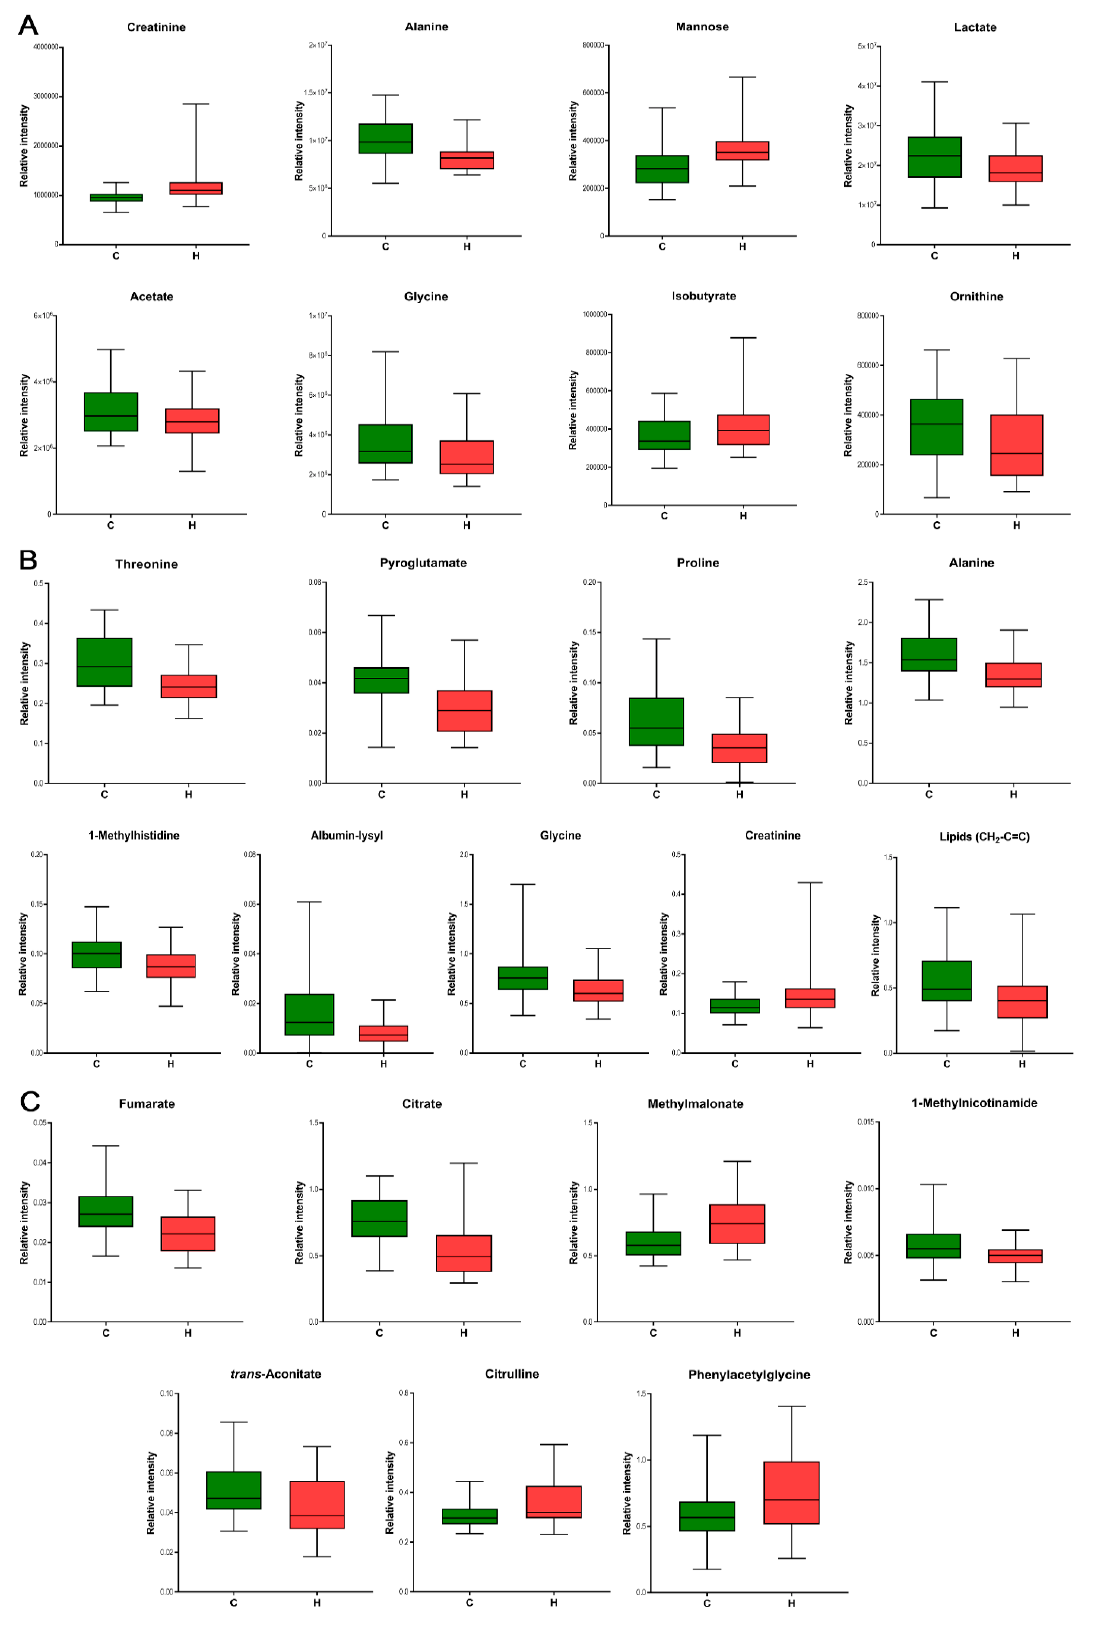
Figure 3. Significantly altered metabolites in the hypertensive group (red box plot) compared to the normotensive group (green box plot) in plasma ( A ), interstitial fluid ( B ), and urine ( C ).